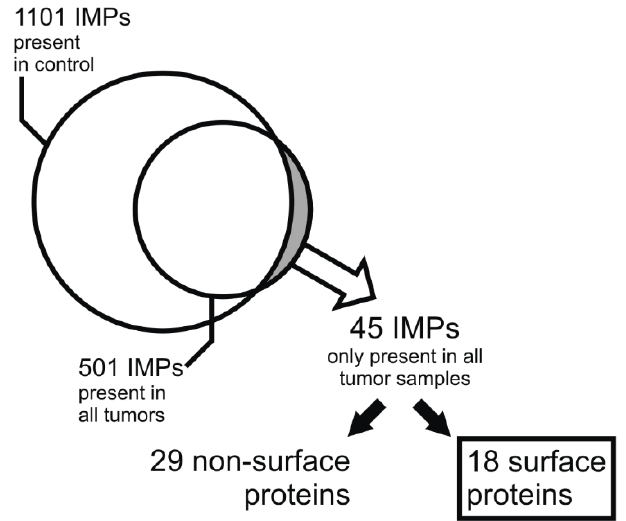
Figure 2. Summary of the bioinformatics workflow leading towards the selection of the candidate proteins. Forty-five IMPs were identified in all five tumors but not found in the control tissue. Of the 45 “tumor enriched” proteins, priority was given to the molecules known or expected to be present on the cell surface. Cell surface localization was determined for 18 “tumor enriched” IMPs using Surface Prediction Consensus scores. Table 2. Eighteen “tumor enriched” integral membrane proteins with cell surface localization were identified in all 5 PGLs but absent in the control adrenal medulla. “TM segments” indicates the number of predicted transmembrane segments/do- mains. Surface prediction consensus (SPC) scores of 3 or 4 indicate a high probability of cell surface localization. Accession